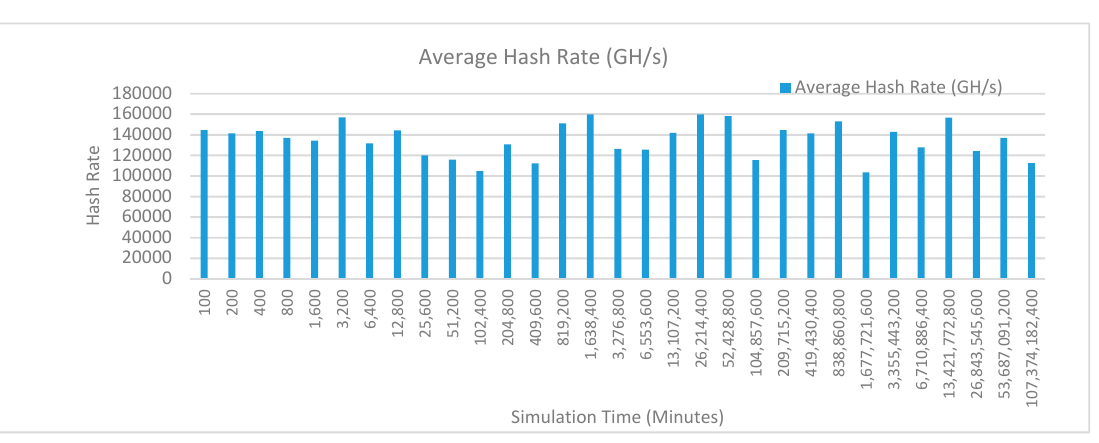
Figure 13. Average hash rate analysis (with IoT, edge, fog).